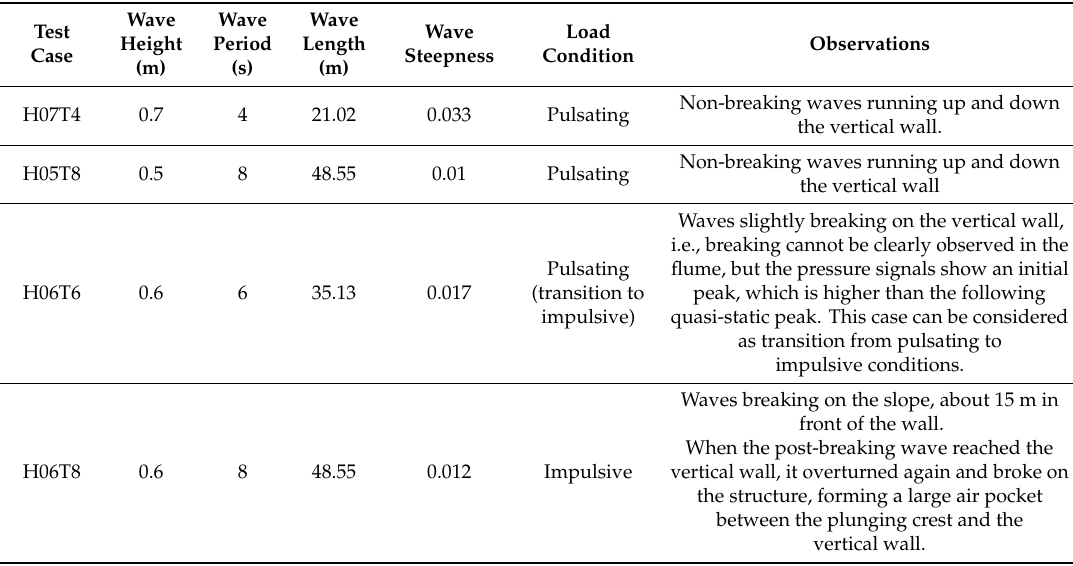
Table 1. Summary of the wave conditions. The wave height and period correspond to the target values, while the wavelength is calculated at the deep section of the flume (d = 4.1